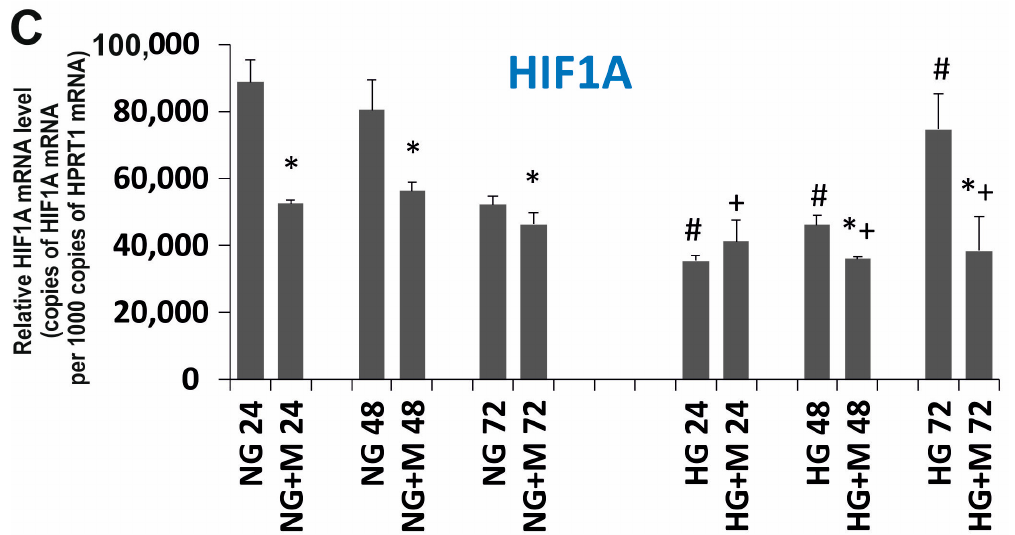
Figure 6. Relative ( A ) SLC2A1 (GLUT1); ( B ) SLC2A3 (GLUT3); ( C ) HIF1A mRNA expression detected after 24, 48, and 72 h in a metformin-treated and untreated ovarian cancer cell line (SKOV-3) cultured in NG and in HG. NG—cells cultured in normoglycemia, NG + M—cells cultured in normoglycemia and treated with metformin, HG—cells cultured in hyperglycemia, HG + M—cells cultured in hyperglycemia and treated with metformin. (*) Statistically significant differences between the cells exposed to metformin in comparison to unexposed cells at the same time points, p < 0.05; (#) statistically significant differences between cells cultured in HG in comparison to those cultured in NG at the same time points p < 0.05; (+) statistically significant differences between metformin-treated cells in HG in comparison to metformin-treated cells cultured in NG at the same time points, p < 0.05.